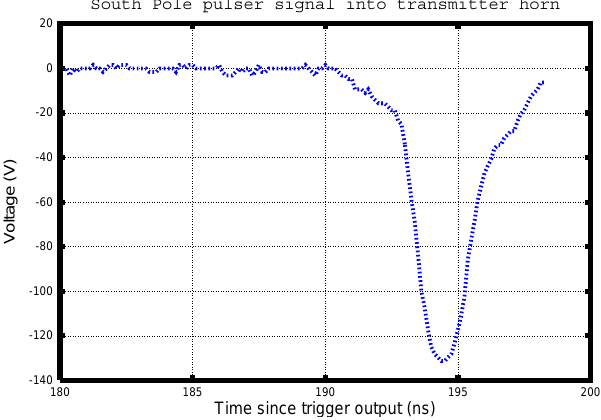
Fig. 2. Pulse generator output signal used for the primary measure- ments described herein. As seen in the figure, the total time delay through the associated cables has been measured to be